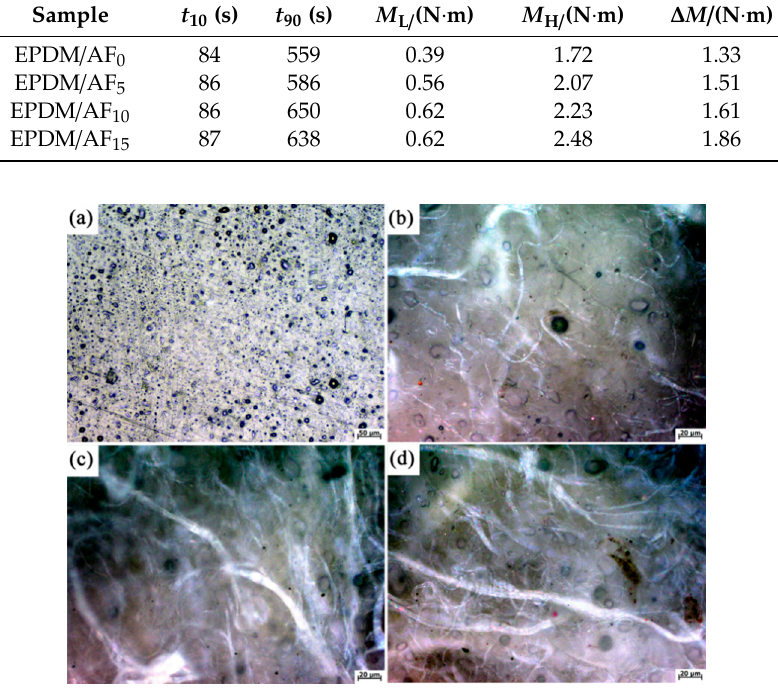
Figure 2. Optical microscopy (OM) photographs of EPDM/AF 0 ( a ), EPDM/AF 5 ( b ), EPDM/AF 10 ( c ), and EPDM/AF 15 ( d ).